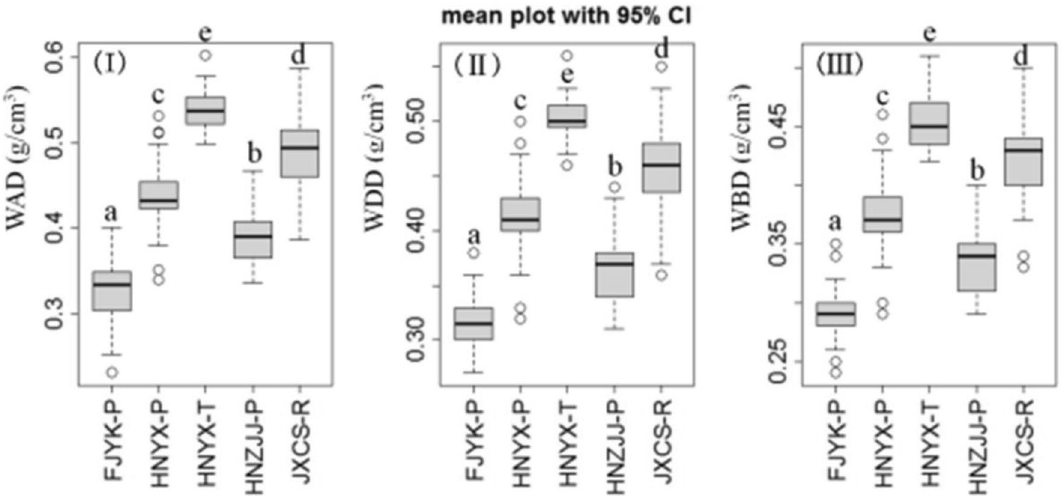
Figure 1. There kinds of wood density in different Chinese fir geographic sources, ( I ) is the wood air-dry density (WAD g/cm 3 ); ( II ) is the wood all-dried density (WDD g/cm 3 ); ( III ) is the wood basic density (WAD g/ cm 3 ). Different letters (a, b, c, d, e) mean significant difference at 0.05 level.